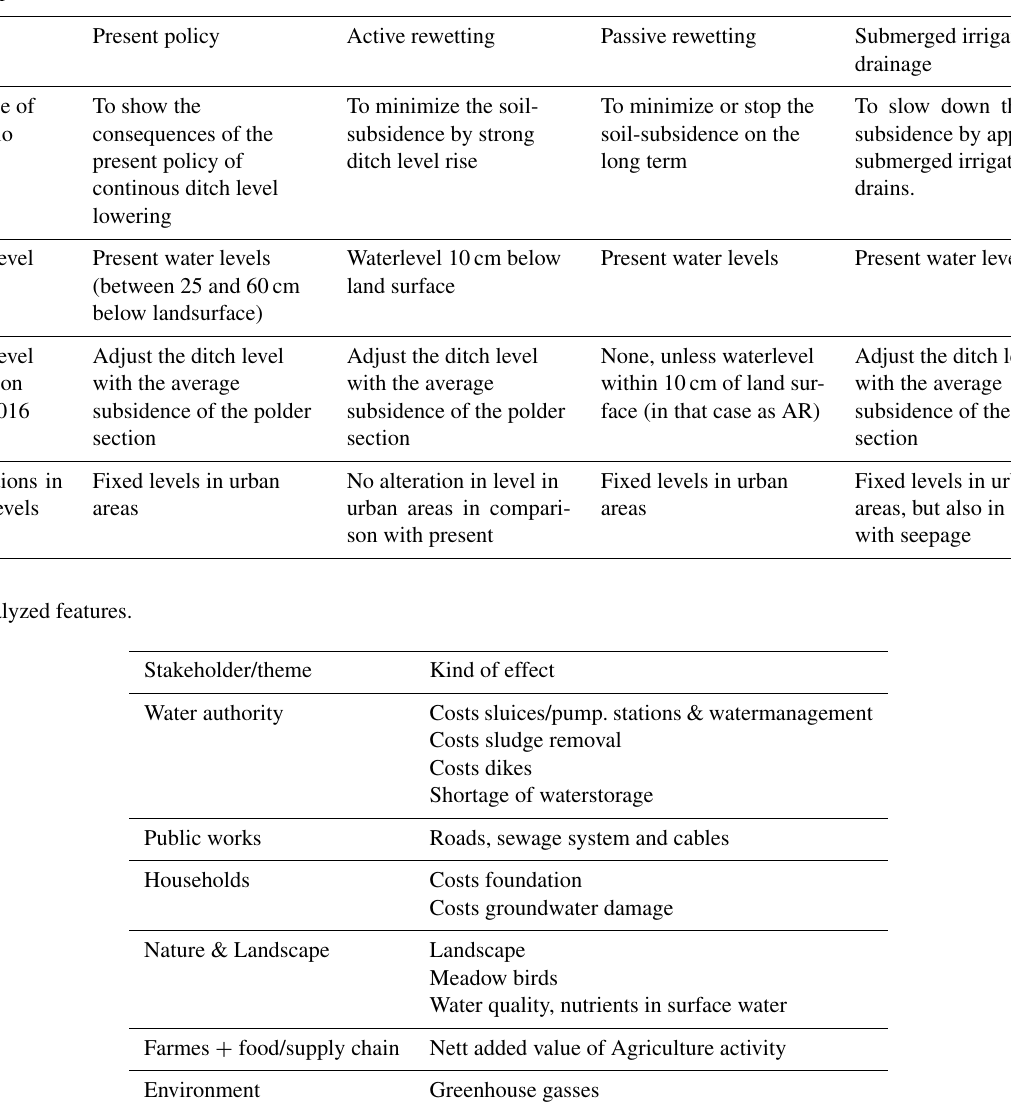
Table 1. The applicable scenarios in the analysis. Scenario